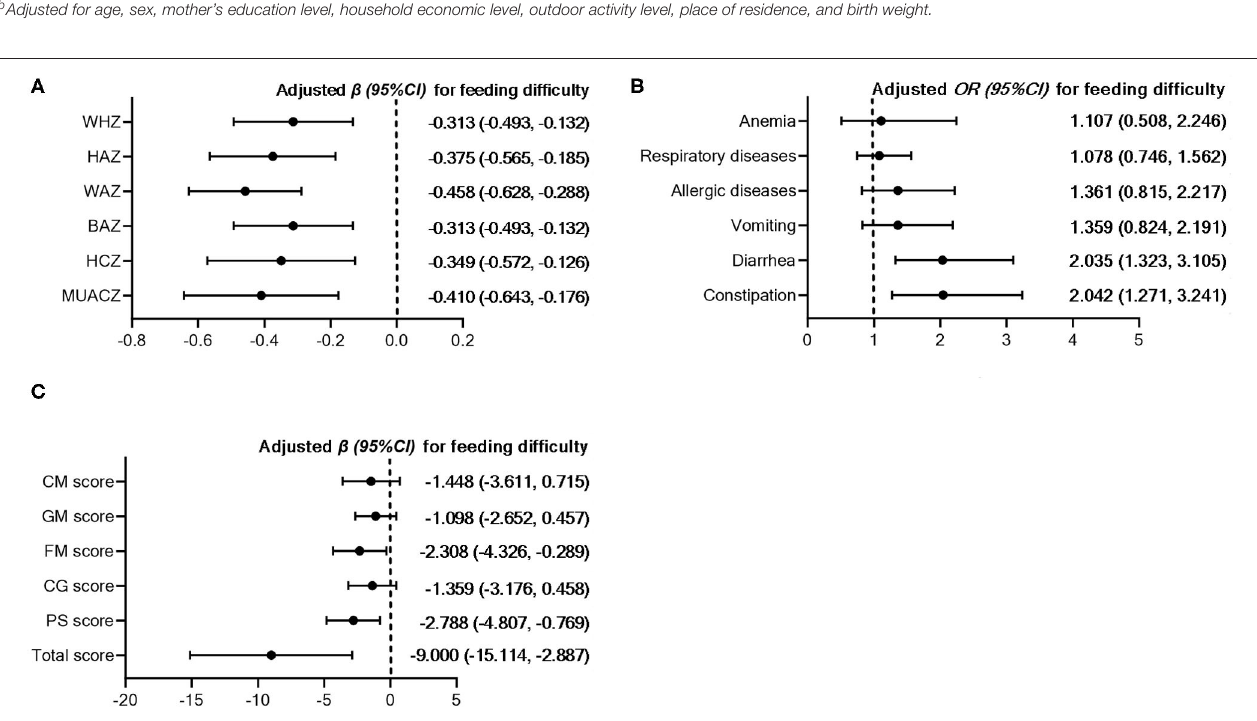
FIGURE 2 | Association between feeding difficulty and anthropometric Z-scores (A) , illness occurrences in recent 3 months (B) and ASQ scores (C) . WHZ, weight-for-height Z-score; WAZ, weight-for-age Z-score; HAZ, height-for-age Z-score; BAZ, body mass index-for-age Z-score; HCZ, head circumference-for-age Z-score; MUACZ, mid-upper arm circumference-for-age Z-score; CM, communication; GM, gross motor skills; FM, fine motor skills; CG, cognition; PS, personal and social skills. Adjusted β (95%CI) or OR (95%CI) were obtained from multivariate linear or logistic regressions using children without feeding difficulty as the